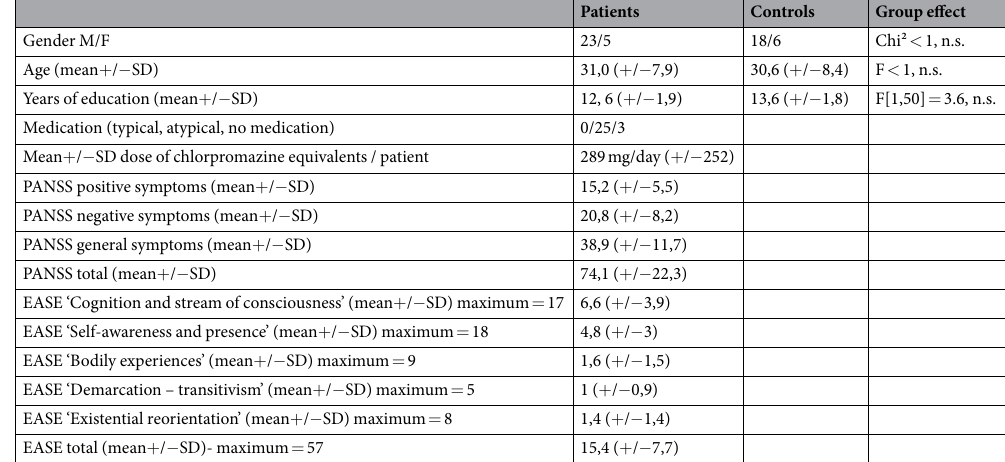
Table 1. Demographic characteristics of each group of